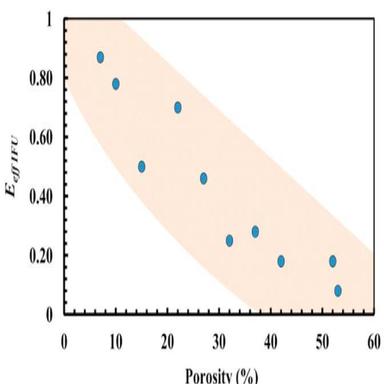
Comparison between IFU data and experimental trends. Young's modulus calculations ( ) are compared with experimental trends acquired by Ref. 48–.